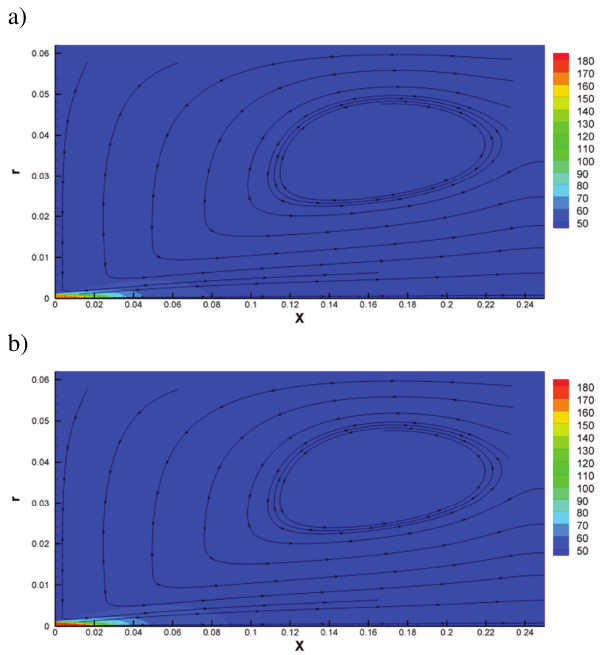
Fig. 5. Density field and streamlines for supercritical case, a) SRK EoS, b) PR EoS